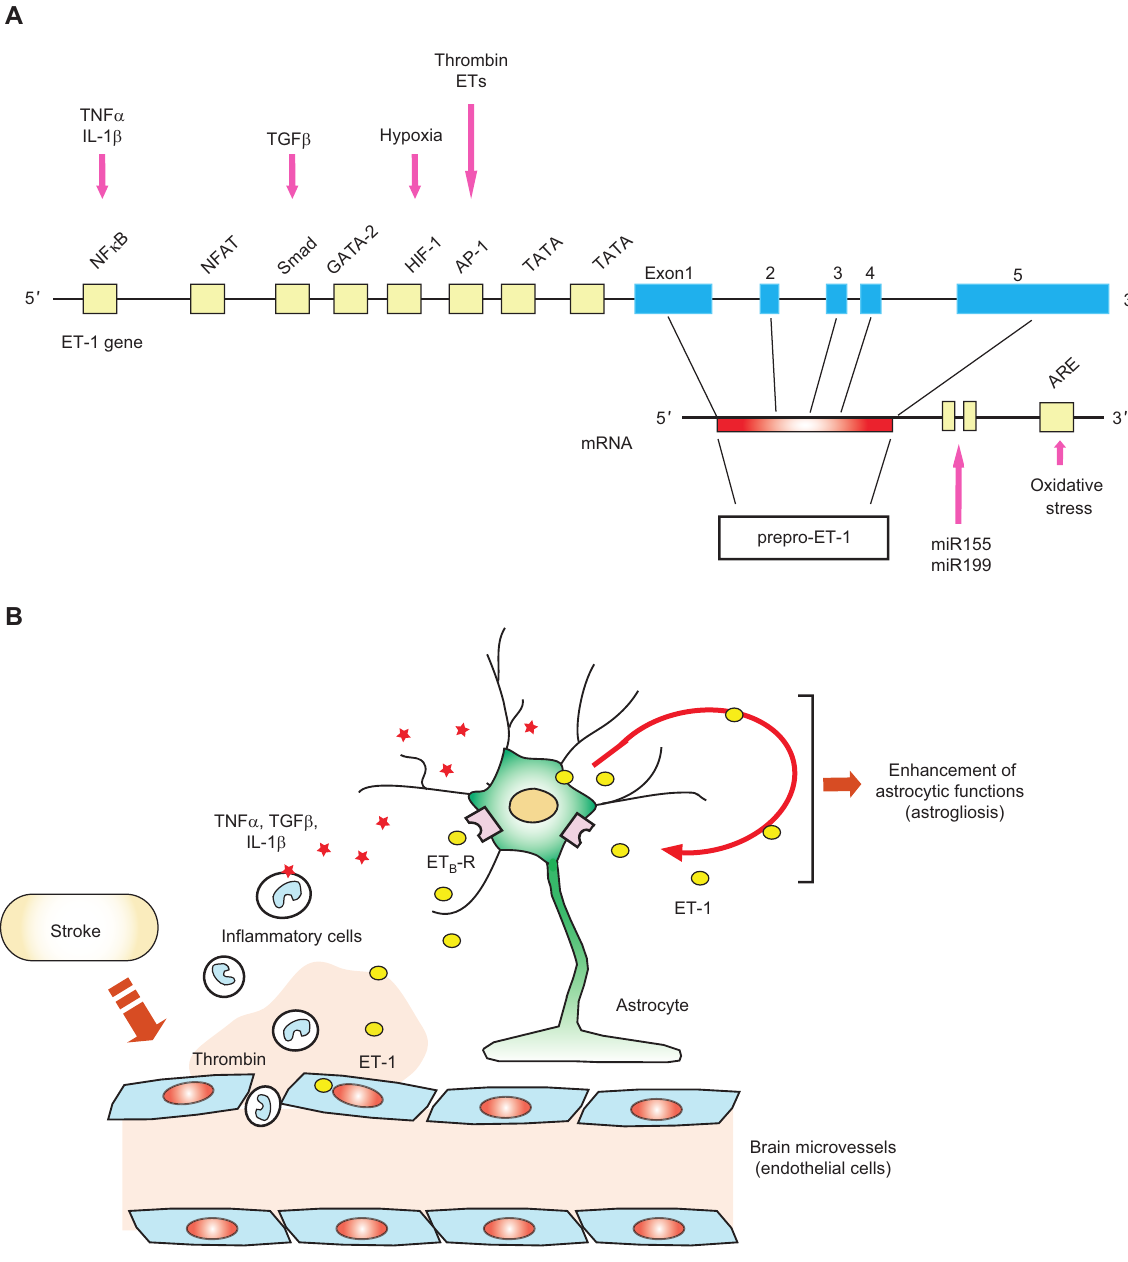
Figure 2 Signaling mechanisms stimulating ET-1